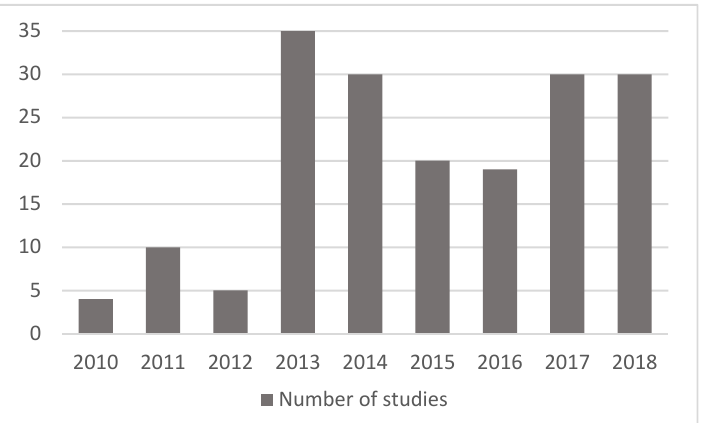
Figure 2. The number of Behaviour Change Games (BCG) studies by year.